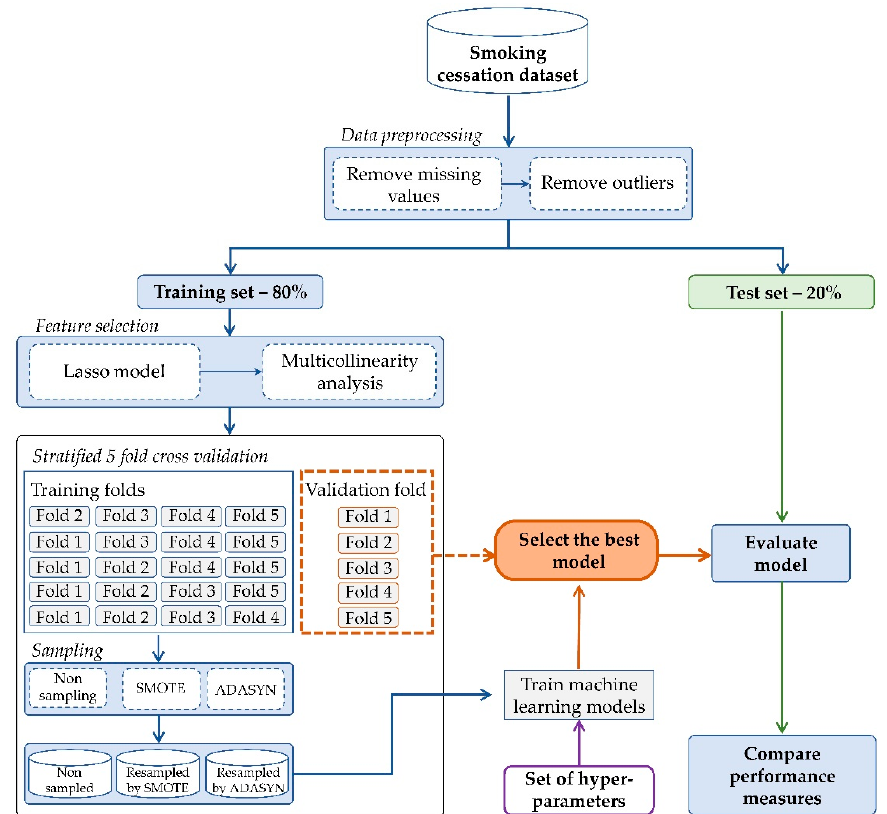
Figure 1. Experimental design for smoking cessation intervention.